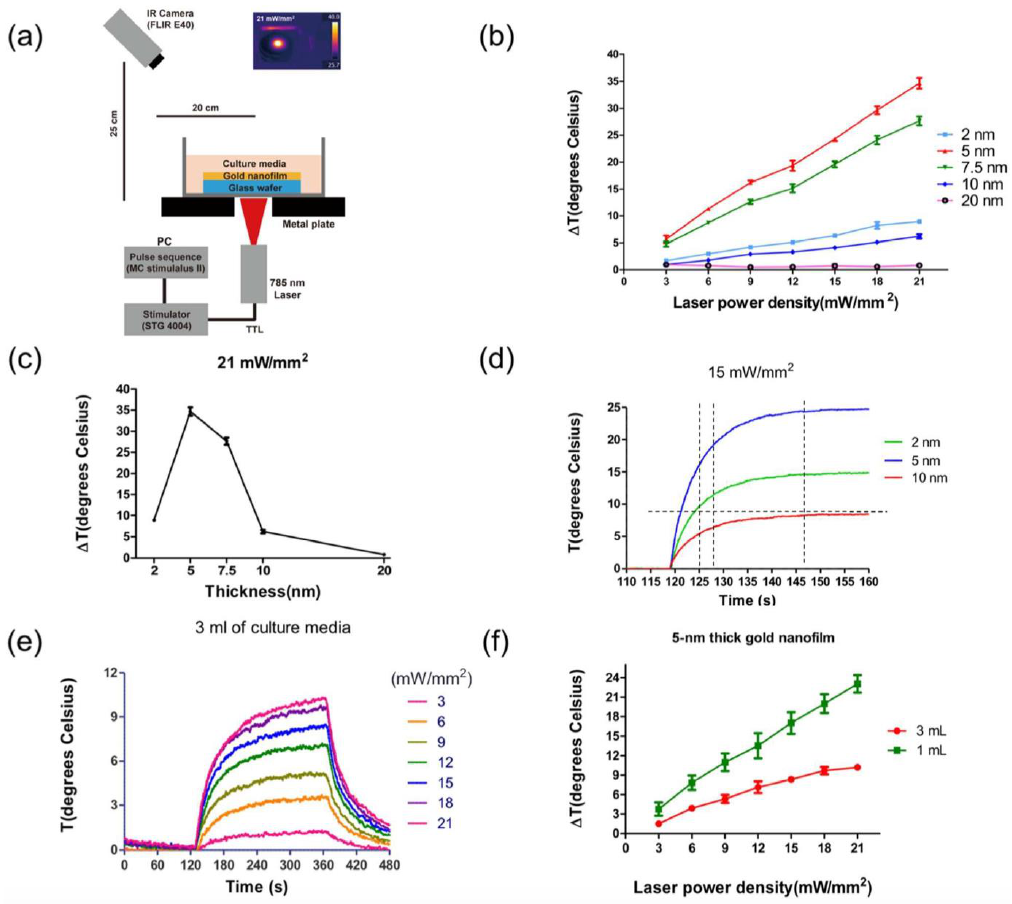
Figure 16. Photothermal behavior of PNF as a function of the thickness of the coating and the laser stimulation parameters. ( a ) Setup of experiment to measure the temperature change under NIR laser irradiation. ( b ) Temperature changes ( ∆ T) of gold nanofilm-coated glass wafer samples ( n = 5) in air conditions when exposed to various laser power densities. ( c ) Maximum ∆ T of various thicknesses of gold nanofilm samples ( n = 5) at 21 mW / mm 2 . ( d ) Heat-up speed extraction of 2-nm, 5-nm, and 10-nm thick gold nanofilm-coated samples at 15 mW / mm 2 . ( e ) Temperature changes of 5-nm thick gold nanofilm sample in culture media. NIR light was turned on at around 120 s and was kept on for 120 s, then shut down immediately. ( f ) Maximum ∆ T of the 5-nm thick samples ( n = 3) in di ff erent volumes of culture media. Error bars represent standard deviation of measurement. Reproduced with permission from [19]. Royal Society of Chemistry, 2018.